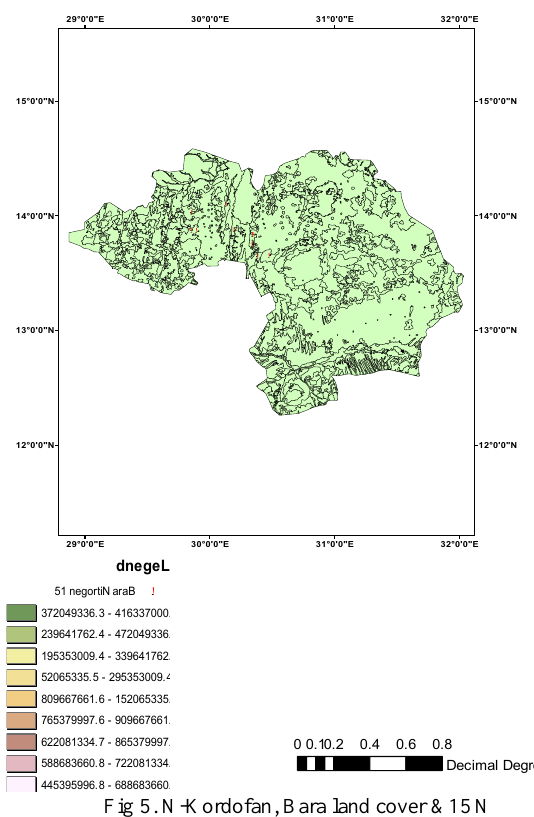
Fig 5. N-Kordofan, Bara land cover &15 N 3. RESULT All isotopic ratios were determined at the Environmental Isotope Lab (EIL) and are reported in delta (δ) notation in units of per mile (‰) relative to atmospheric N2 (Air) and Vienna Standard Mean Ocean Water (VSMOW), and supported by SUD8010y project in (table 3, 4) standards for δ15N and δ18O, respectively